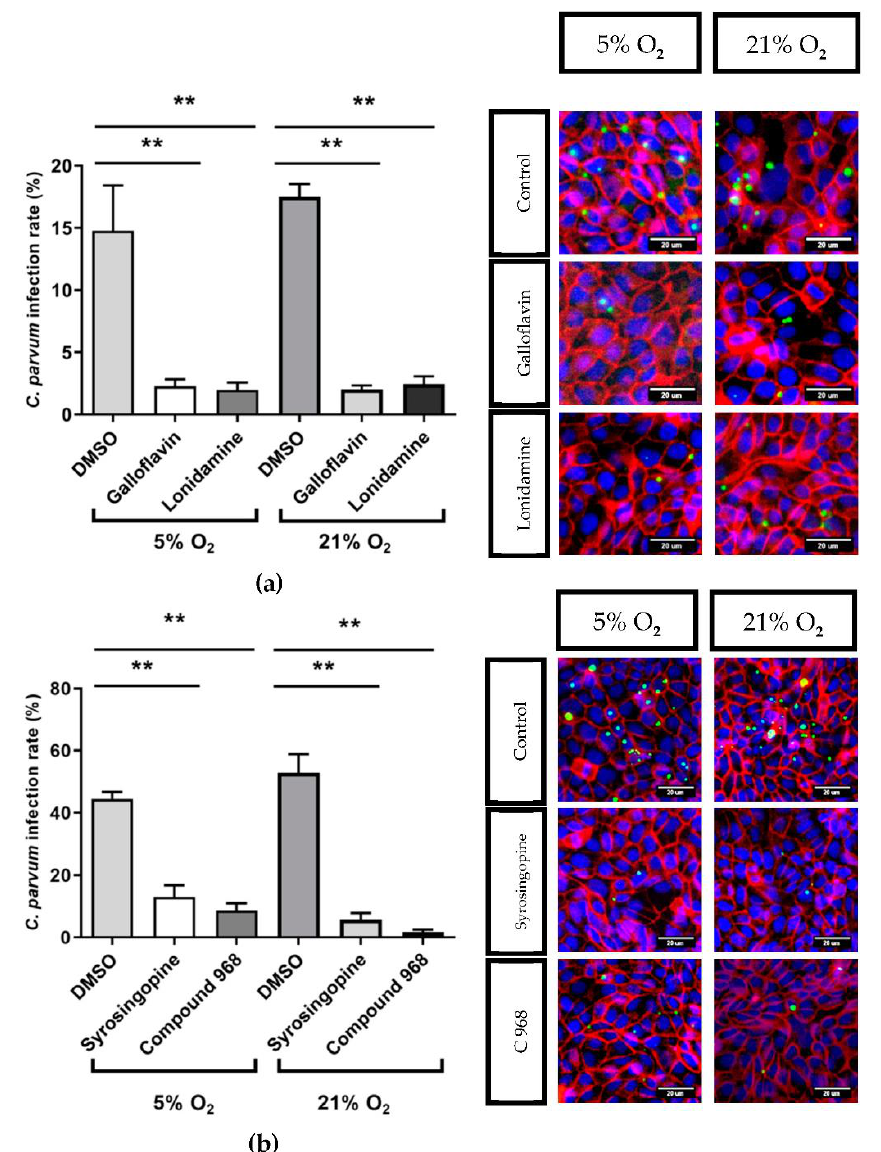
Figure 8. Effects of galloflavin (400 µ M), lonidamine (150 µ M) ( a ), syrosingopine (10 µ M) and compound 968 (10 µ M) ( a , b ) treatments on C. parvum infection rates in HCT-8 cells cultivated at 21% O 2 and 5% O 2 , and exemplary illustrations of respective inhibition assays. C. parvum was stained with VVL, green; host -cell membranes and nuclei were labelled with anti-ß-catenin (red) and Hoechst (blue), respectively. Bars show means ± SD, ( n = 6). For evaluation of significance t -test was performed. ** = p ≤ 0.01.